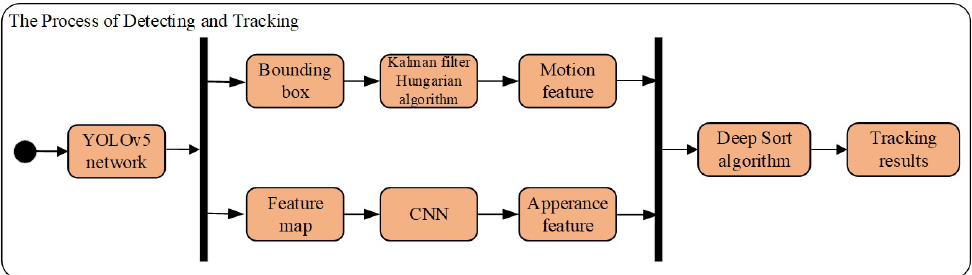
Figure 2. The process of detecting and tracking. We adopted YOLOv5 as the detector and extract motion features and appearance features based on the Kalman filter and Hungarian algorithm to input into the Deep SORT algorithm to get tracking results.